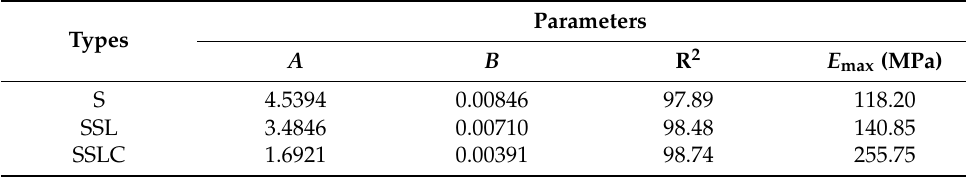
Table 4. The fitting parameters of dynamic modulus.